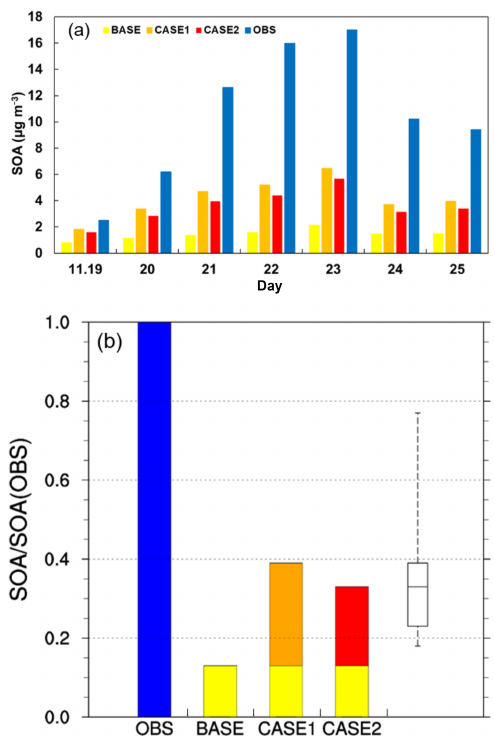
Figure 6. Comparisons of SOA between simulations and observa- tions at the WQS monitoring site: (a) time series; (b) ratios of tem- poral average SOA concentration to observed SOA concentration during the study period (the box represents the uncertainty range in SOA prediction, the central line is the ratio in CASE2, and the edges of the box are the ratios in CASE4 and CASE5, the edges of the whiskers are the ratios in CASE3 and